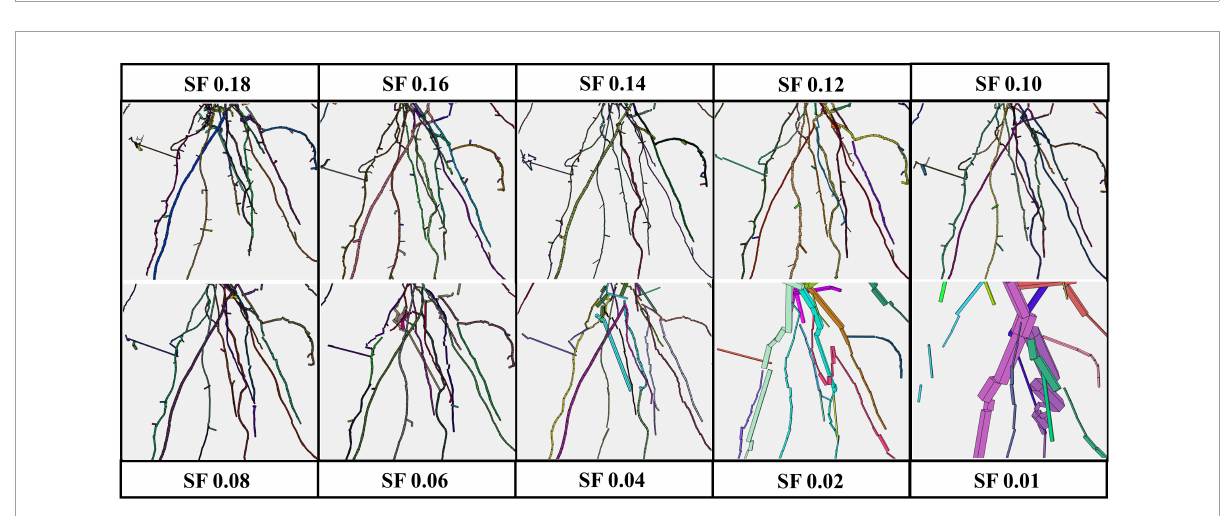
FIGURE3 Zoom of the red window from Figure 2 [root model results using several scale factors (SFs) from 0.01 to